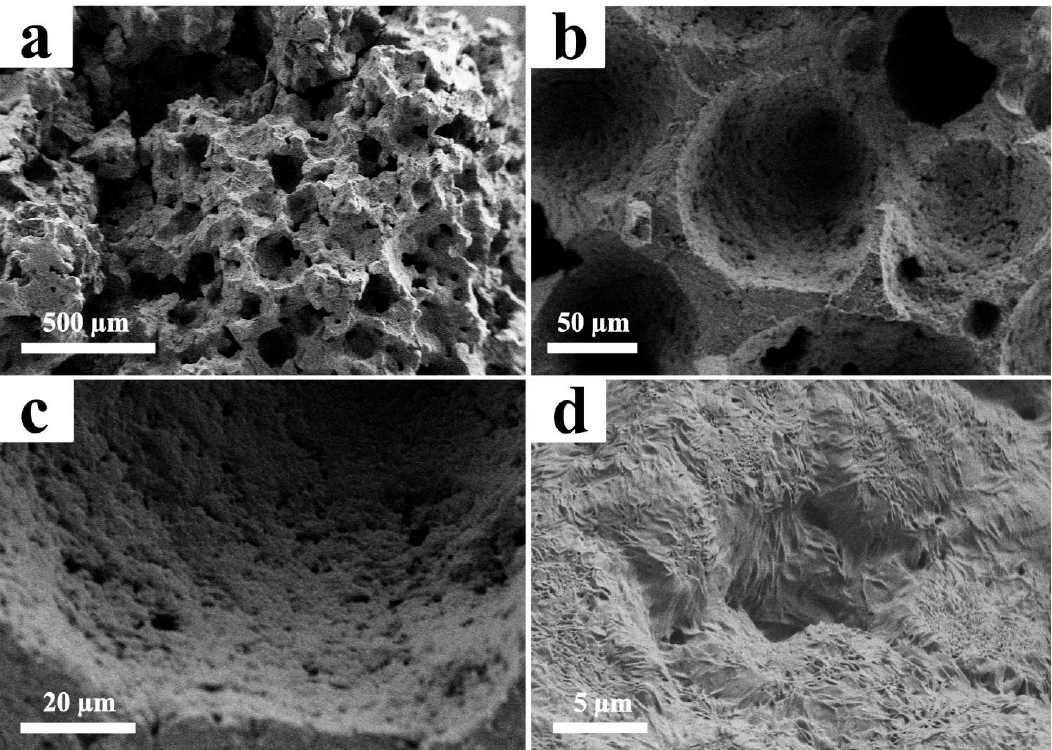
Figure 3. SEM images of PCL/rGO produced at 180 atm. ( a – d ) demonstrate different magnifications of scaffold structure. The time in the supercritical medium is 60 min, the decompression rate is 100 atm/s, and the rGO concentration is 1 wt. %.